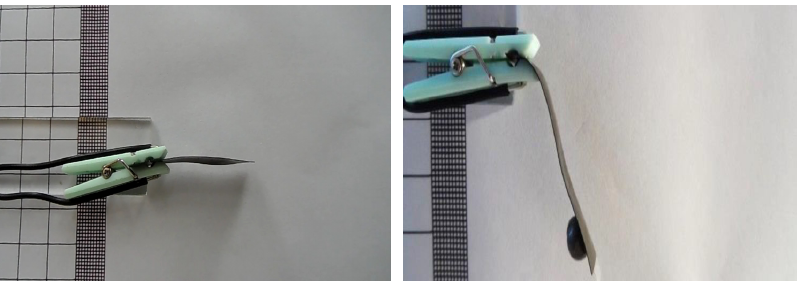
Figure 6. Displacement measurement of the tested polymers under load conducted in